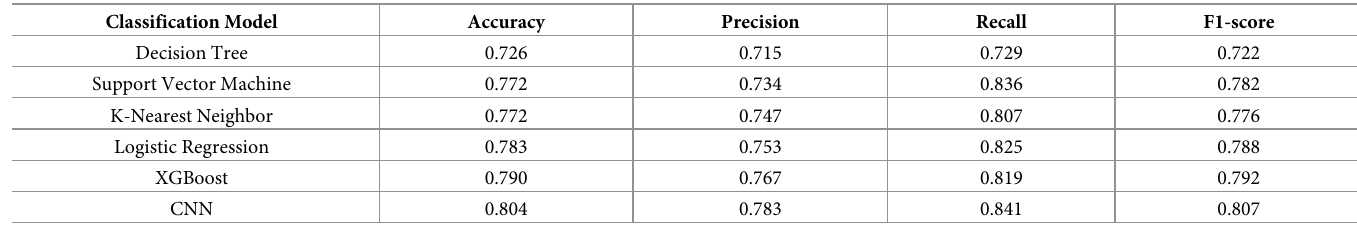
Table 4. Prediction model analysis